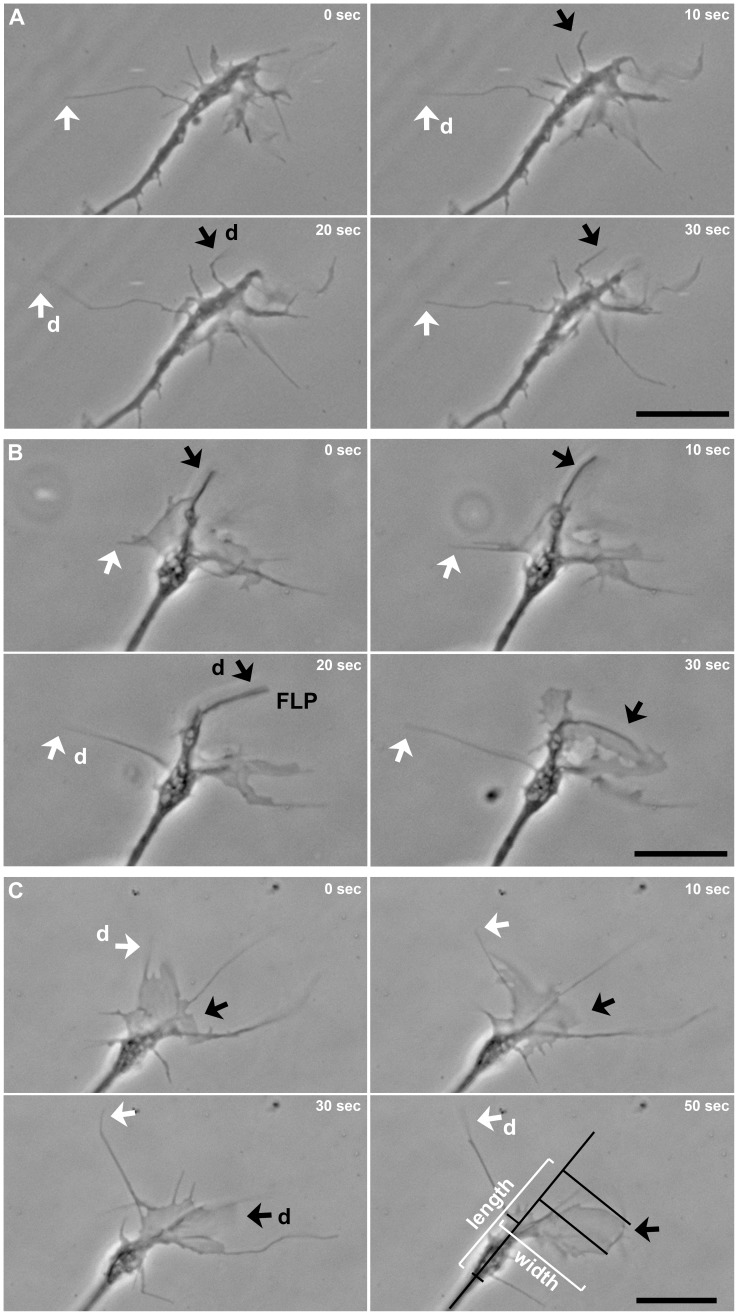
Dynamics of growth cone protrusions on nanopatterns.(A) Time-lapse phase contrast micrographs of a growth cone on an 86 nm ALCAM pattern show two filopodia (white and black arrows) which detach (d, move out of focus; 20 sec) from the substratum and reattach (again in focus; 30 sec). (B) Another example of a filopodium (white arrow) and a stronger, finger-like protrusion (FLP, black arrow) detaching and reattaching; (C) also a lamellipodium (black arrow) de- and reattaches. Length and width of a growth cone were determined as indicated by white and black lines. Scale bars, 10 µm.